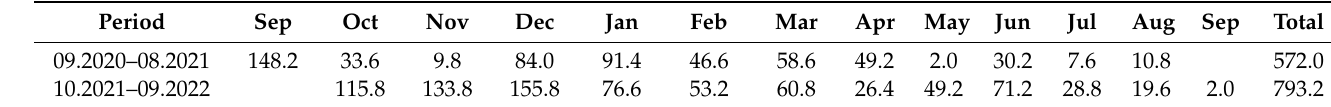
Table 3. Precipitation values (in mm).